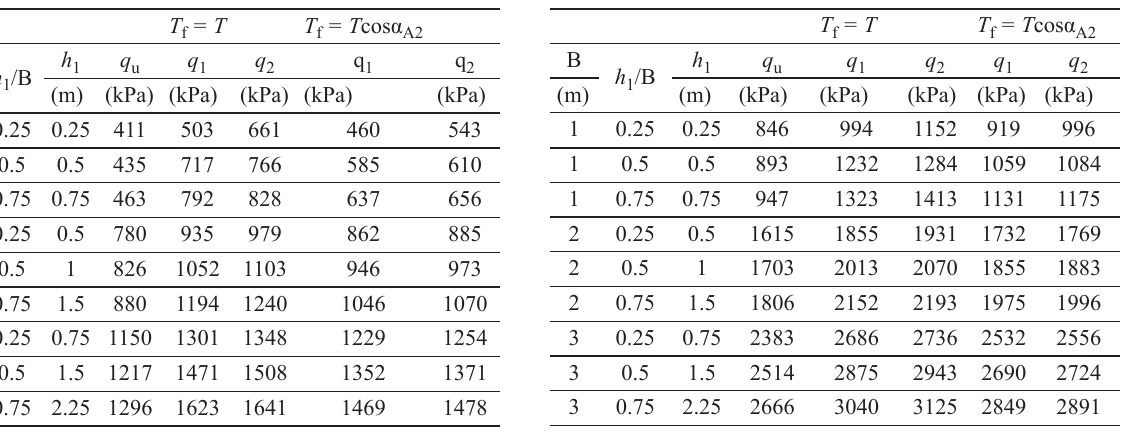
Table 3. Bearing capacity obtained from the new Limit equilibrium method ( ϕ = 34° on ϕ = 31°)